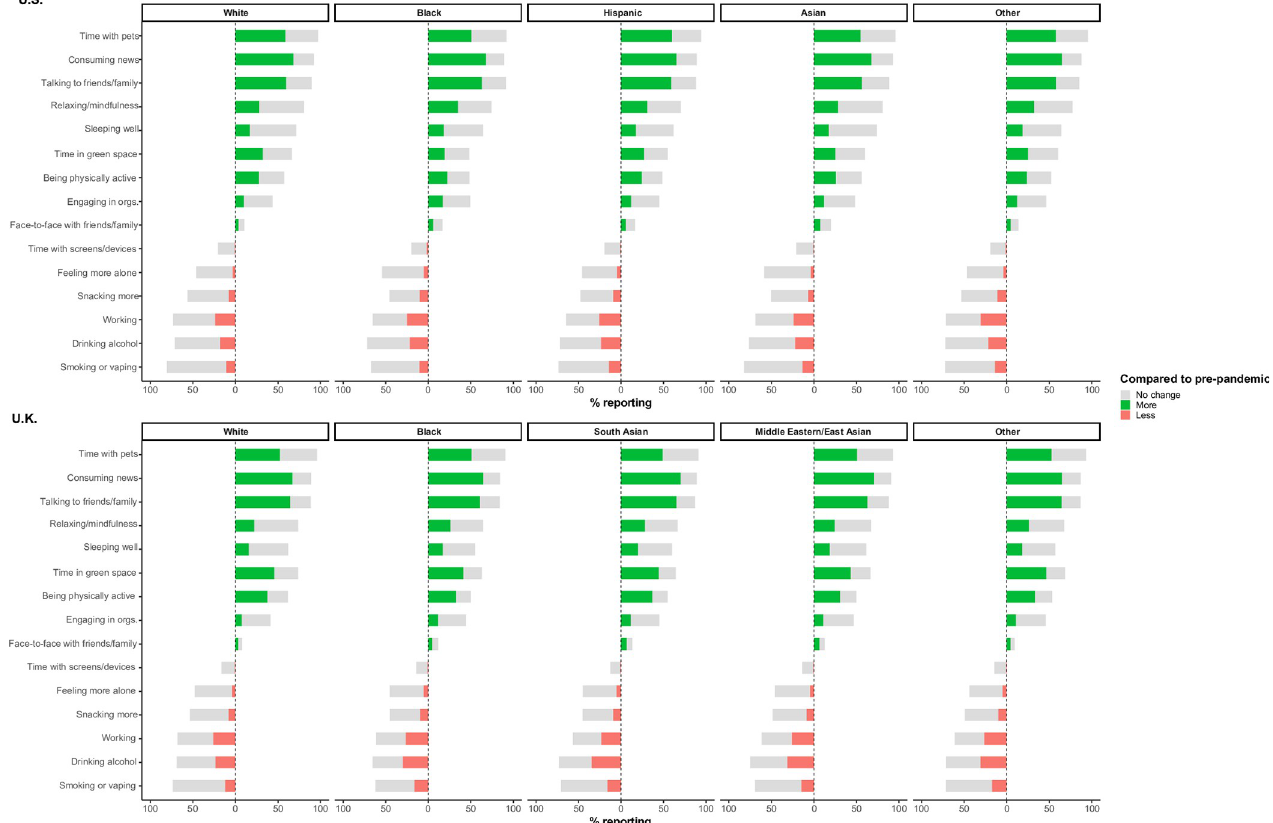
Fig 2. Changes in peri-pandemic behavior by race and ethnicity. Proportions have been rescaled among individuals to whom a given question was deemed applicable (i.e., time spent with pets reported among pet owners). Stratified analyses conditioned upon age, sex, and date of mental health questionnaire completion, and adjusted for personal history of mental health diagnosis, diabetes, heart disease, lung disease, kidney disease, current smoking status, body mass index, prior reported history of COVID-19 infection, HCW status, and community-level education, income, and lockdown stringency except in a given strata. Referent is White individuals of the same